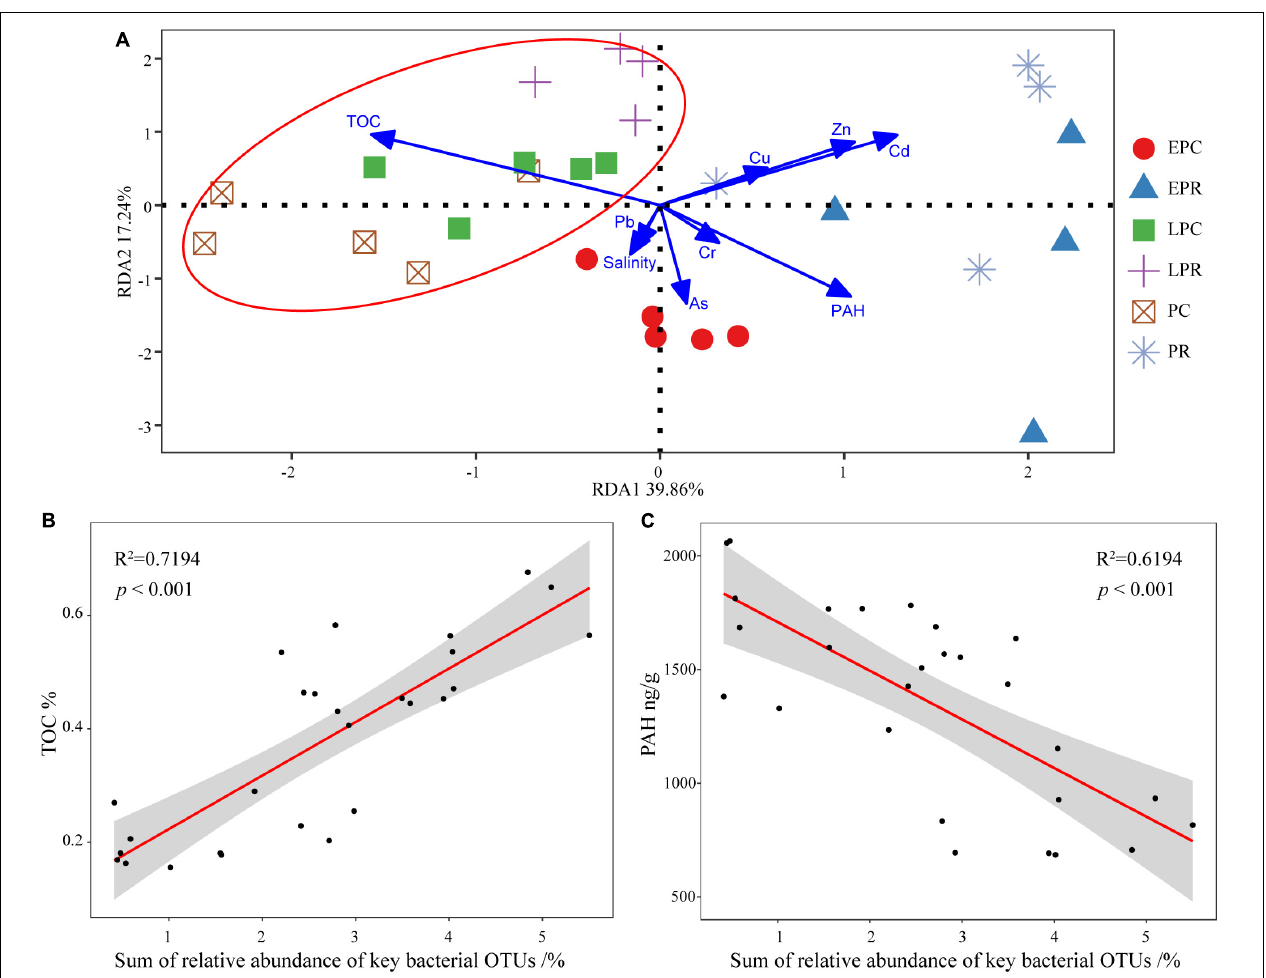
FIGURE 6 | The relationship between bacterial community structure and environmental factors. (A) Redundancy analysis (RDA) analyze the relationship between bacterial community and environmental factors in different groups. The shape and color of the point stands for different groups. Linear-regression analysis between the sum of relative abundance of key operational taxonomic units (OTUs) and total organic carbon (TOC) (B) , and polycyclic aromatic hydrocarbon (PAH) (C)